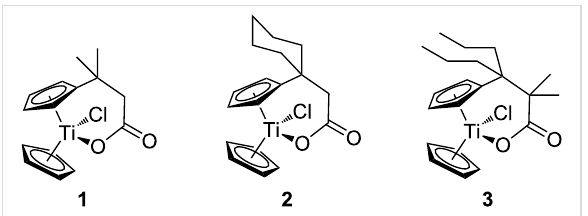
Figure 1: Carboxylates employed as titanocene starting materials for azide-substituted